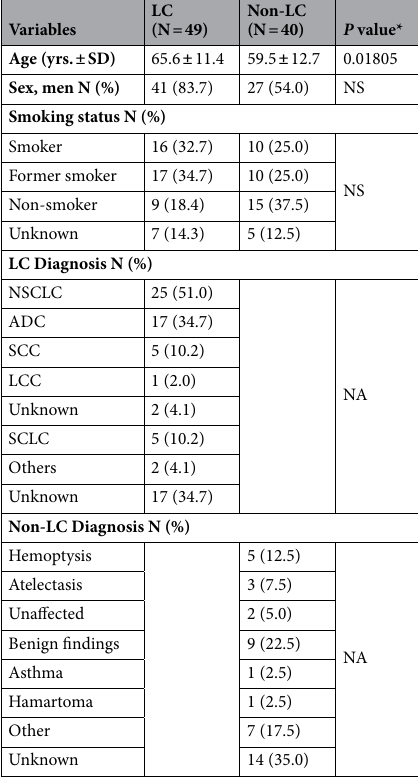
Table 1. Demographic and clinical data of the extended BALF dataset. * P values based on Welch’s t-test or chi-square (normal distributed or categorical variables, respectively) for the comparison lung cancer (LC) and non-LC groups. NS—non-significant ( p value > 0.05). NA—not